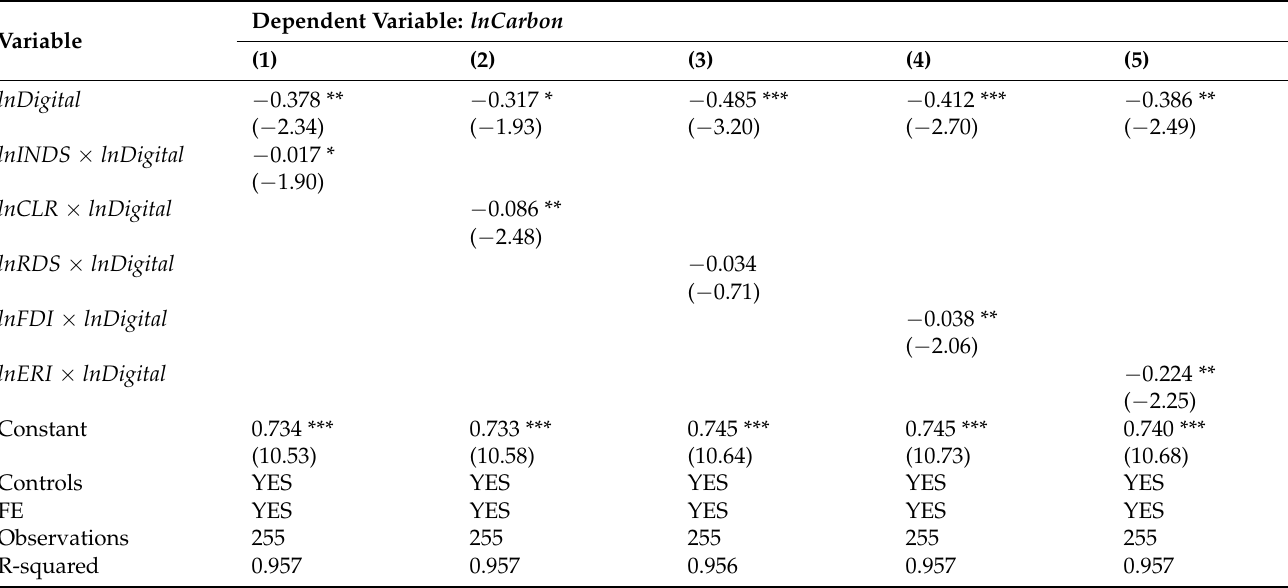
Table 8. Mechanism test results for the effects of manufacturing investment in digitization to reduce carbon emission